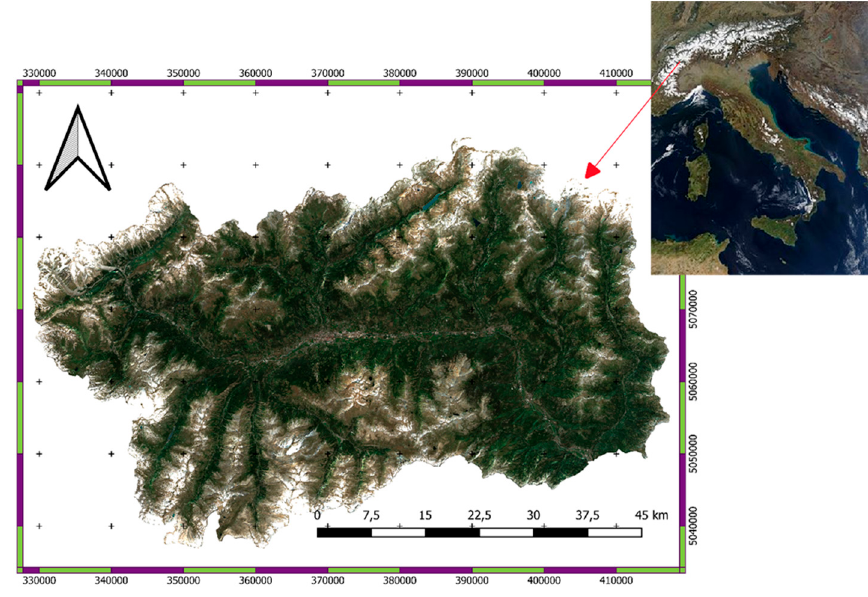
Figure 1. EO geospatial service area of interest. Aosta Valley autonomous region in NW Italy (ED50 UTM 32N)